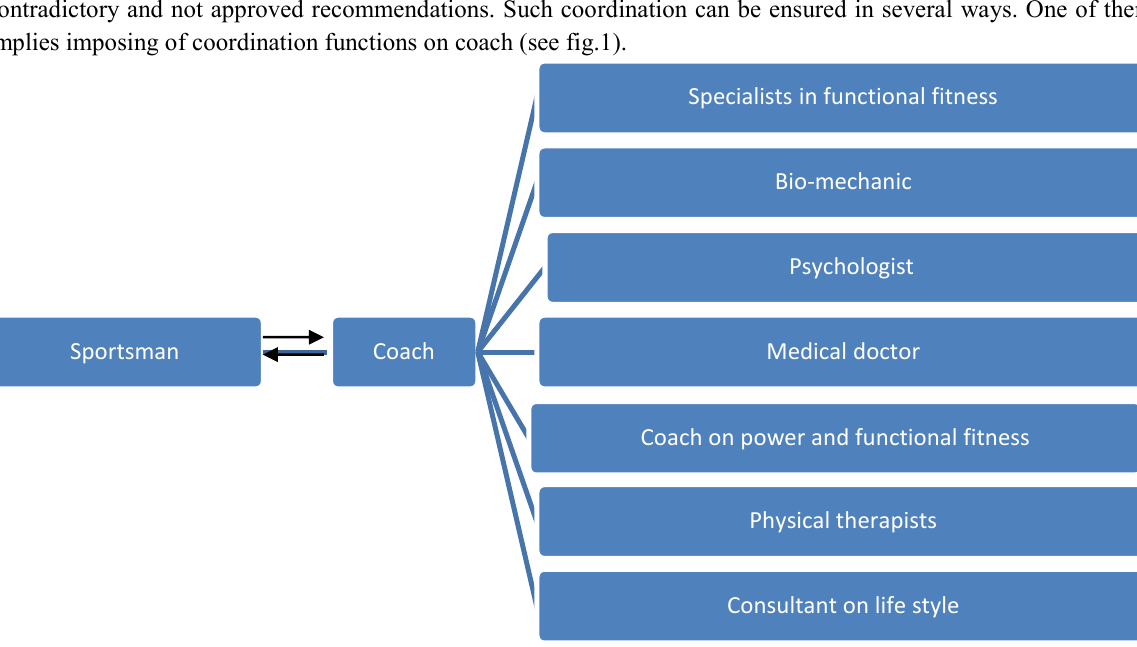
Fig. 1. Training system, controlled by coach (Abraham, Collins,